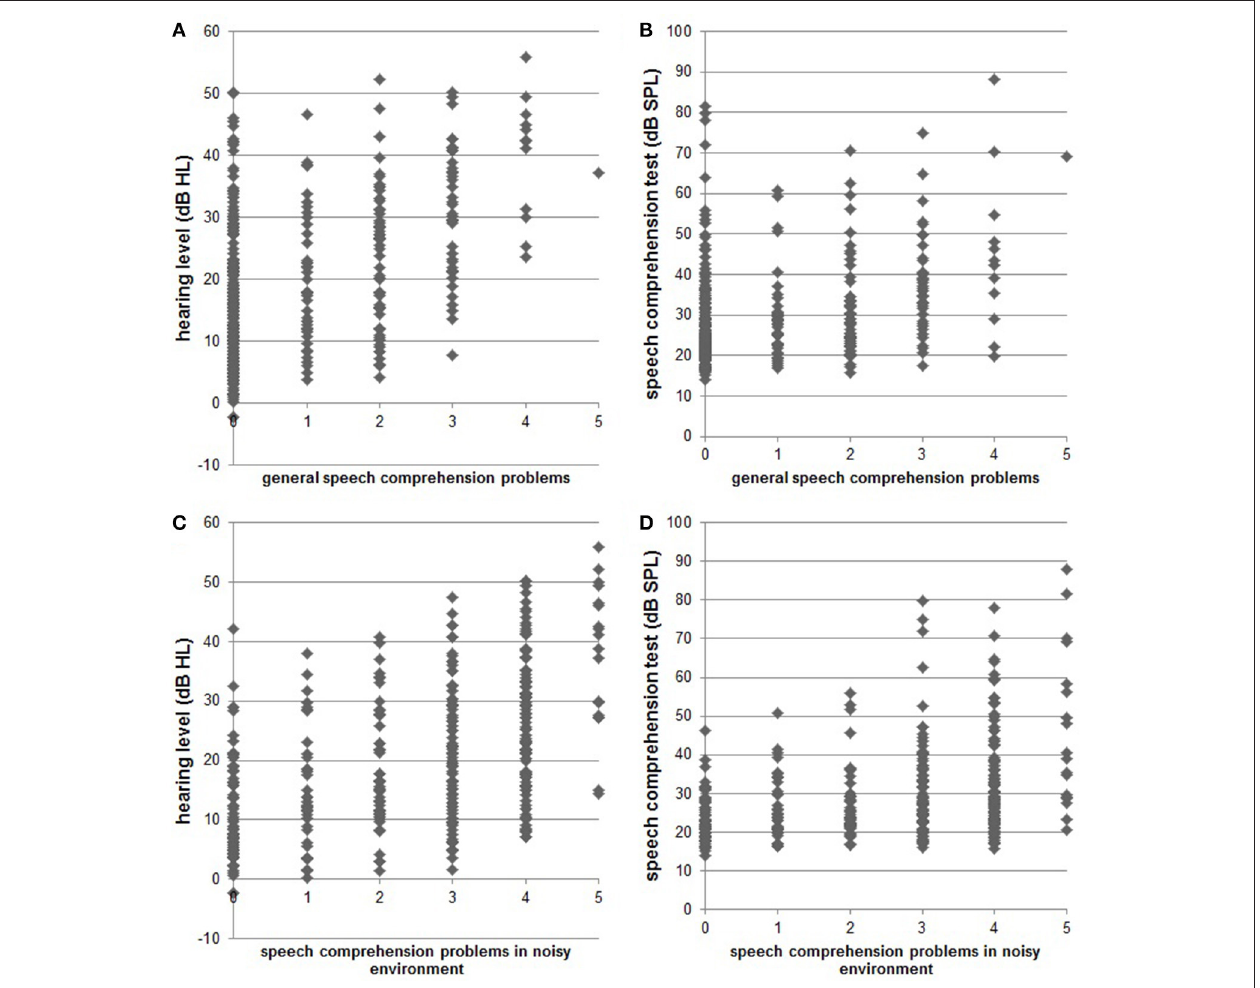
FIGURE 2 | Scatter plots indicate single subject data for hearing status [pure tone audiogram; (A) : r = 0.474; (C) : r = 0.517] and speech comprehension status [results from Goettingen sentence test; (B) : r = 0.351, (D) : r = 0.387] compared to the subjective speech comprehension report in quiet and in noisy environments,